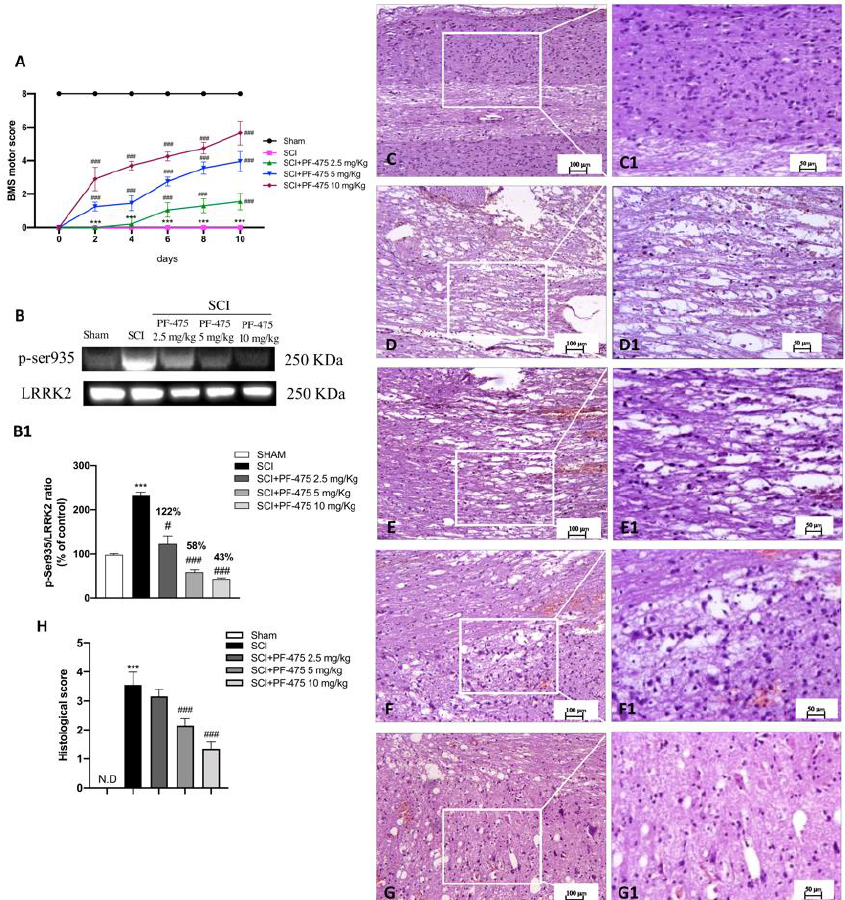
Figure 1. Effects of PF-475 treatments on motor disturbance, phosphorylated LRRK2 at Serine 935 expression, and histological features after SCI. BMS open-field score was performed for 10 days after SCI ( A ). Motor function was not altered in sham mice (black line) compared with SCI- injured mice (pink line), while PF-475 (5 and 10 mg/kg) significantly restored motor functions (blue and purple lines). Representative Western blot of phosphorylated LRRK2 at Serine 935 protein expression level in cytosolic fraction of spinal cord tissues after SCI and PF-475 treatments ( B , B1 ). The samples used derive from the same experiment and those gel/blots were processed in parallel. Hematoxylin and eosin ( H , E ) staining of Sham group ( C , C1 ) and SCI group (( D , D1 ), see histological score ( H )). PF-475 treatments after SCI: PF-475 2.5 mg/kg (( E , E1 ) see histological score ( H )); PF-475 5 mg/kg (( F , F1 ); see histological score ( H )) and PF-475 10 mg/kg (( G , G1 ); see histological score ( H )). Each data is expressed as SD from ten mice for each group. One-way ANOVA followed by Bonferroni post-test and two-way ANOVA followed by post hoc test for multiple comparisons. (ND) Not detectable. *** p < 0.001 vs. sham, # p < 0.05 vs. SCI; ### p < 0.001 vs.